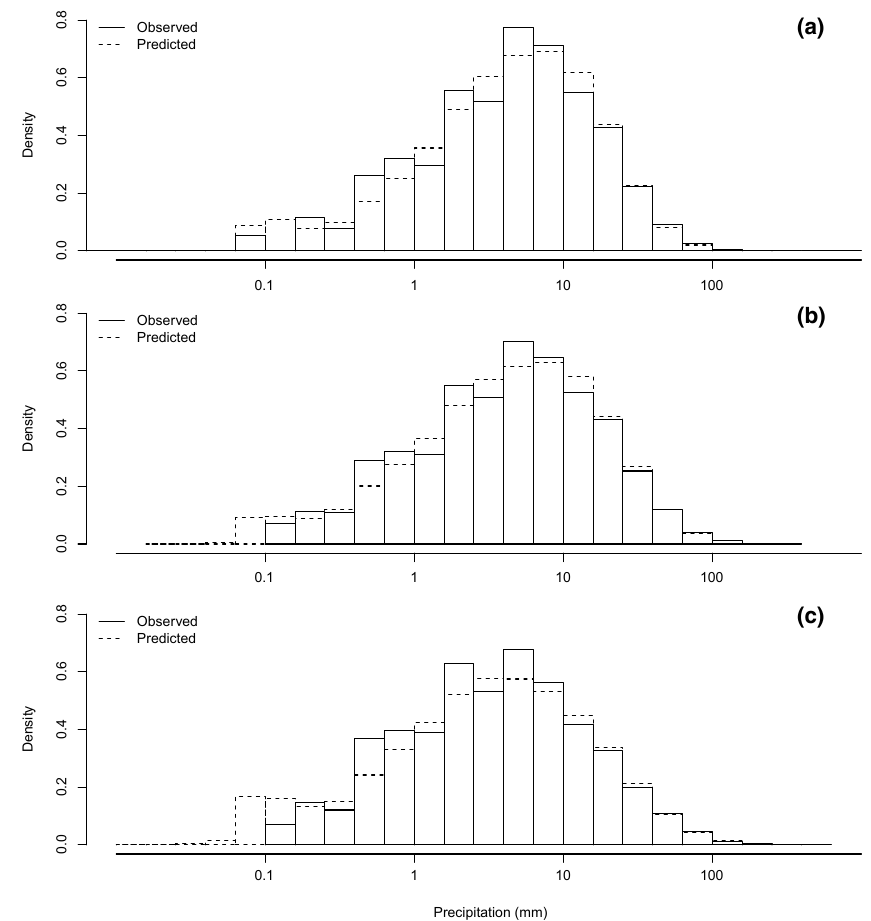
Figure 4. Histograms of observed and predicted daily precipitation frequency in (a) peninsular Spain, (b) the Balearic Islands and (c) the Canary